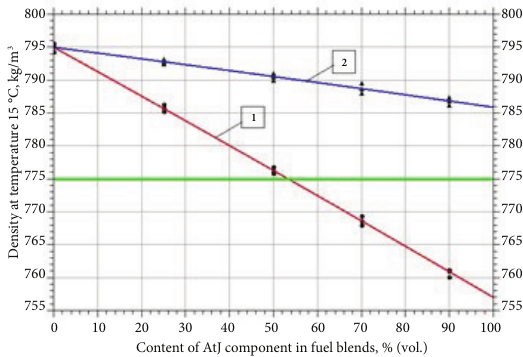
Figure 3. Dependence of the density of JF blends on the content of AtJ components produced from alcohols: 1 – AtJ-SPK component, 2 – AtJ-SKA